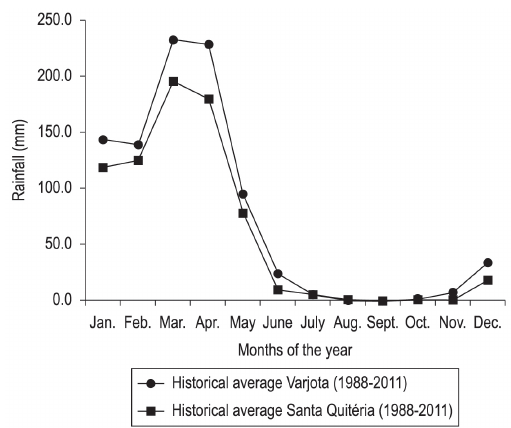
Figure 2. Historical average monthly rainfalls (1988-2011) in the municipalities Varjota and Santa Quitéria (Ceará, Northeastern Brazil) where the Paulo Sarasate and the Edson Queiroz reservoirs are located, respectively. Source: FUNCEME